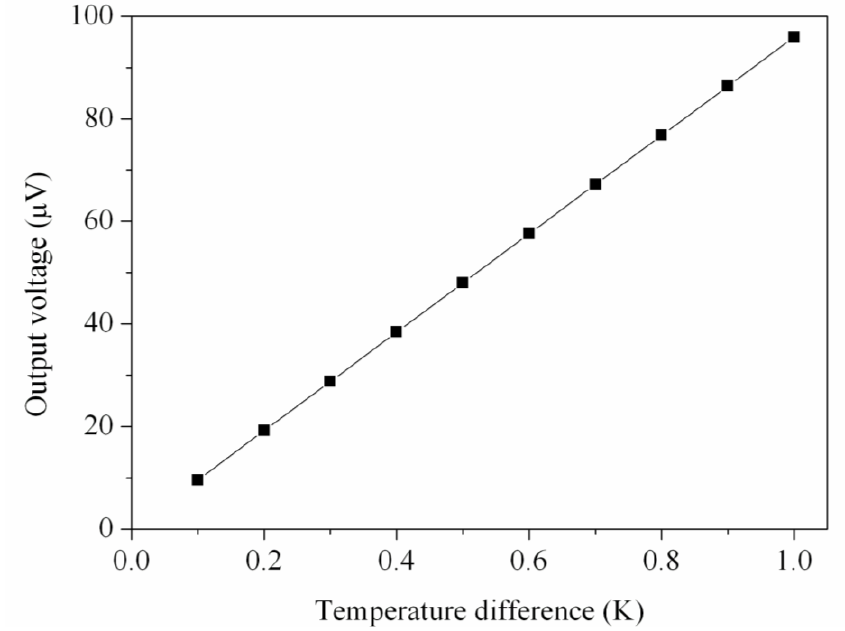
Figure 4. Simulated results of the output voltage for the